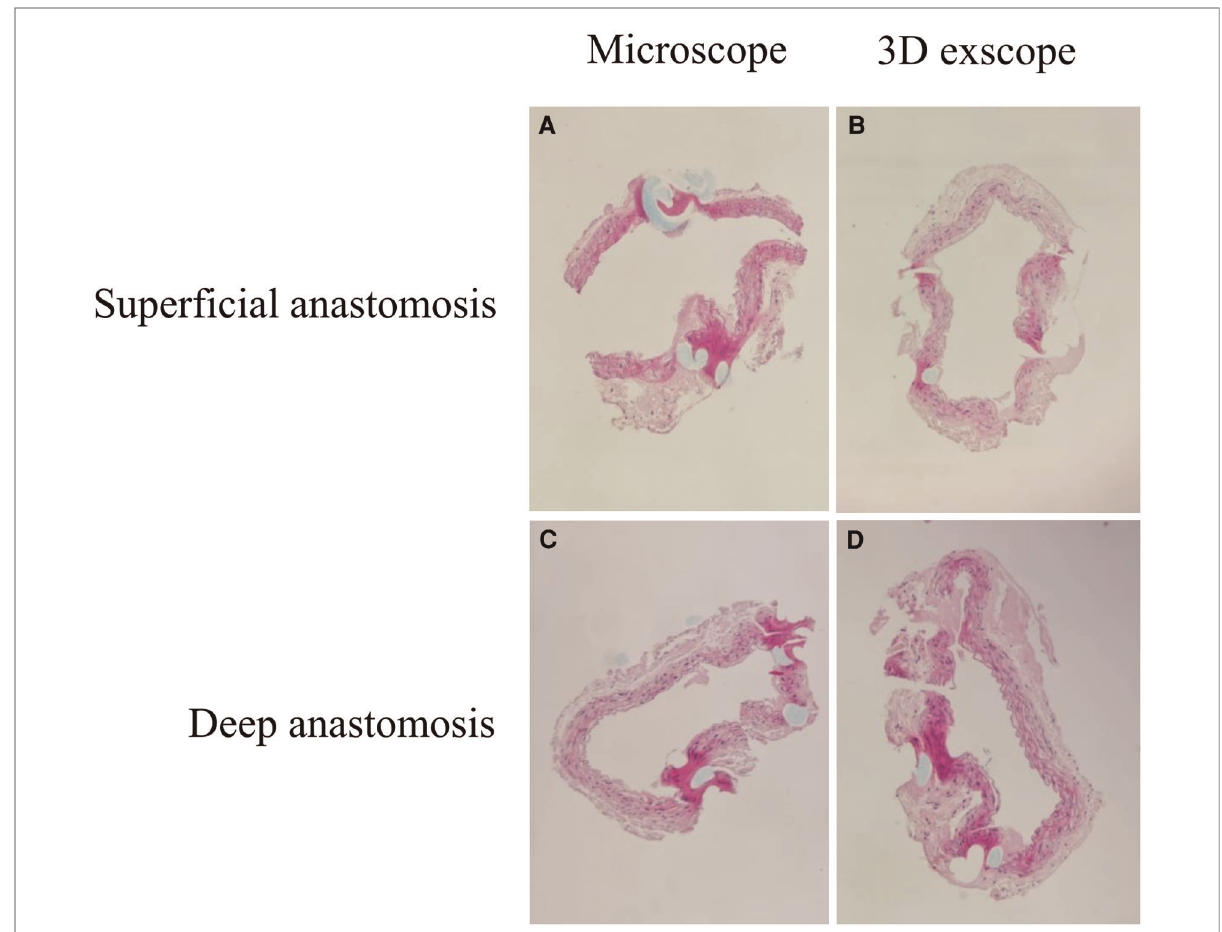
FIGURE 3 Typical HE staining results (power of magni fi cation: 100×). ( A ) Super fi cial anastomosis using a conventional microscope. ( B ) Super fi cial anastomosis using a 3D exoscope. ( C ) Deep anastomosis using a conventional microscope. ( D ) Deep anastomosis using a 3D